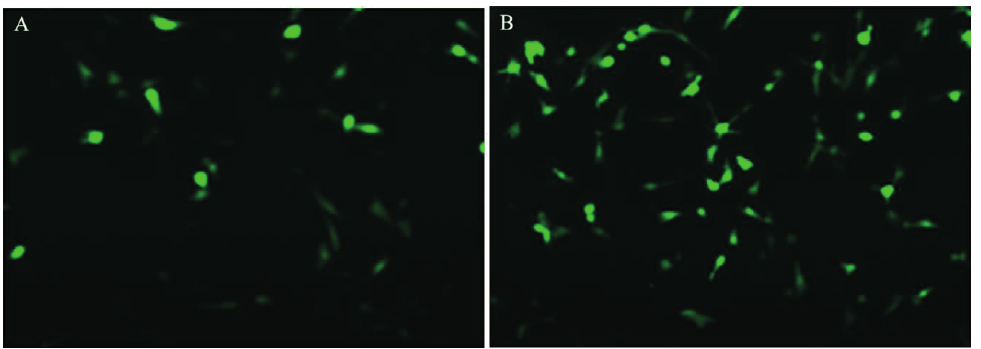
Figure 2: MiRNA-132 expression after transfection of renal epithelial cells in rats through miRNA-132 plasmids; (A) miRNA-132 nc and (B) miRNA-132 . Scale bar = 50 μm.